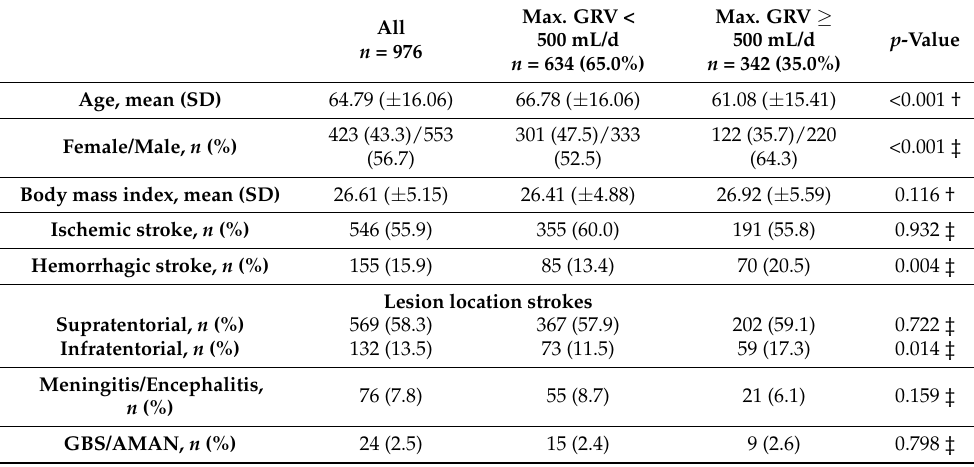
Table 1. Epidemiological and clinical parameters and group test according to GRV.